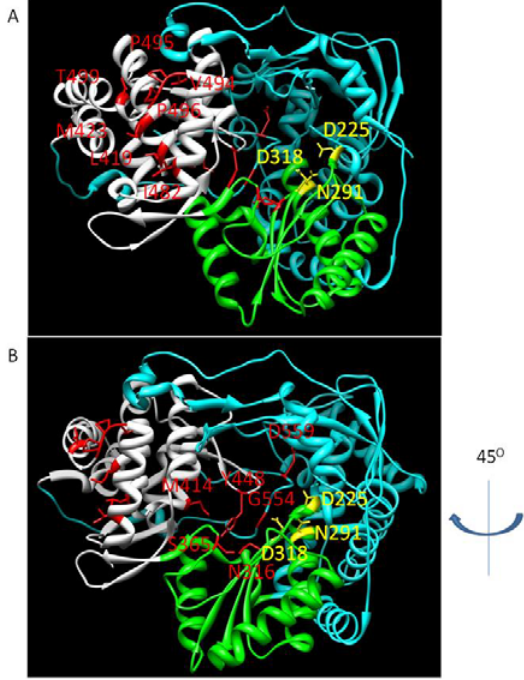
green. A: highlights the positions of NNI site I and II resistance; B: is a 45 degree rotation of the structure, highlighting sites for resistance to NNI site III and IV